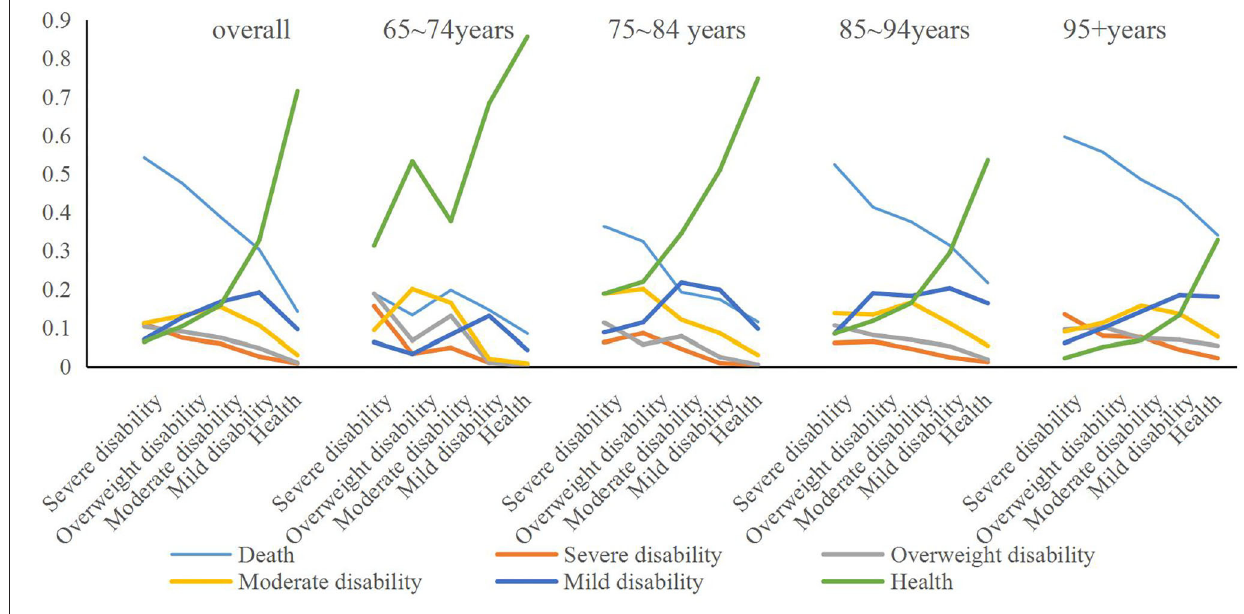
FIGURE 1 | Disability state transfer chain under different age